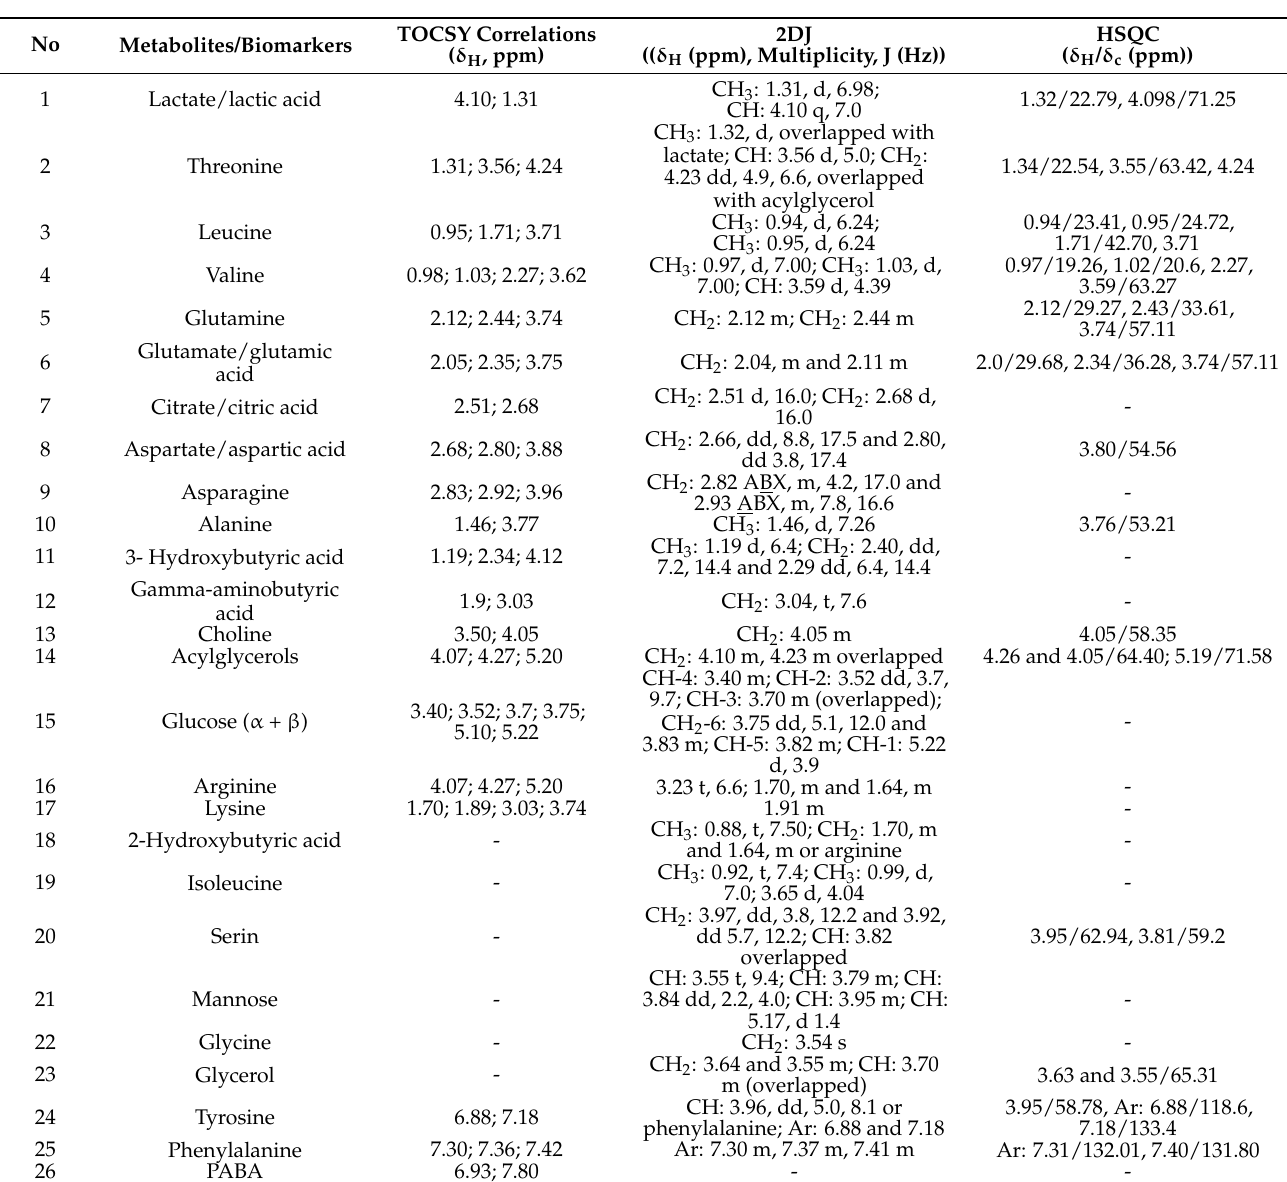
Table 2. Metabolites/biomarkers identified in schizophrenia patients’ serum samples, with spec- tral